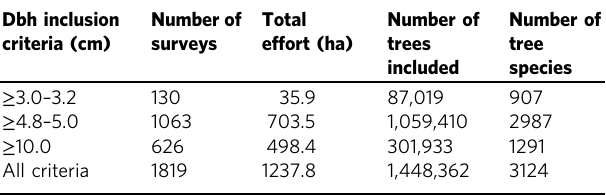
Table 1 Summary of the Atlantic Forest surveys